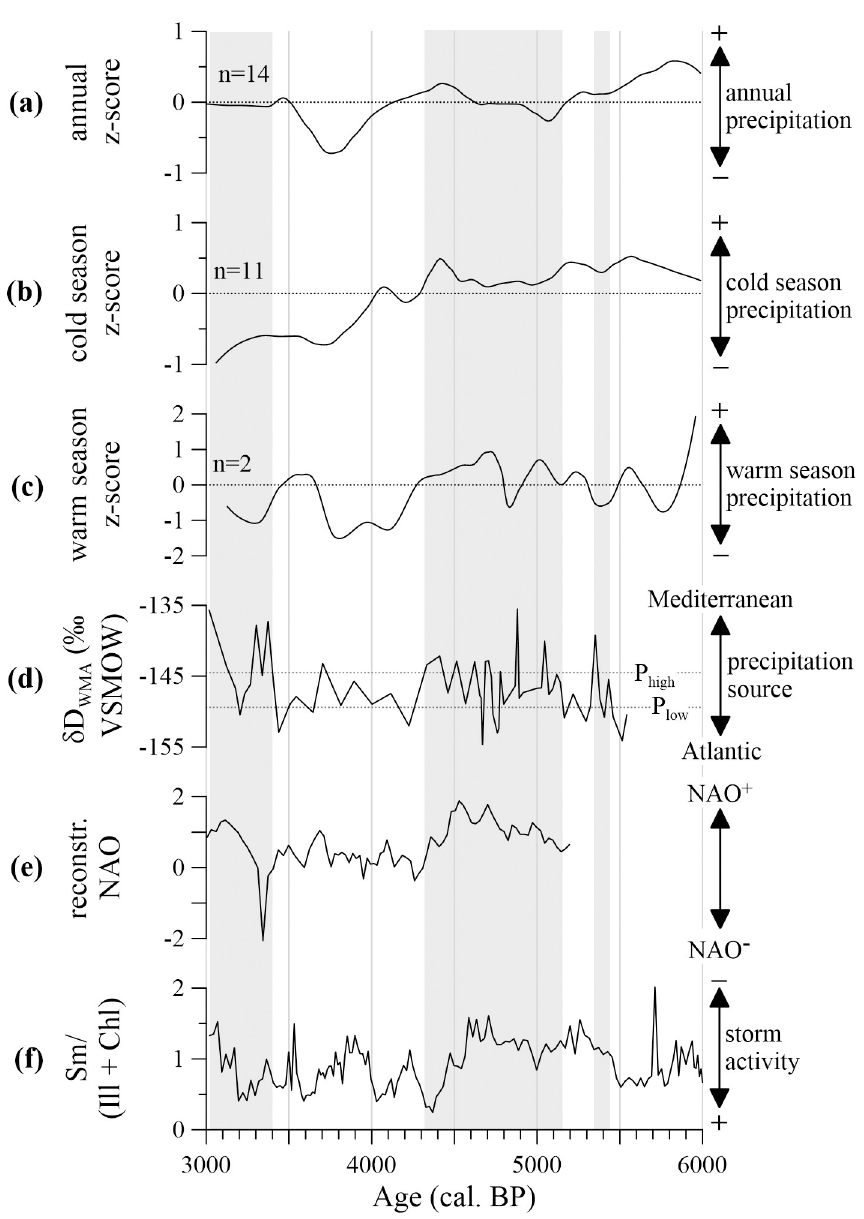
Fig 4. Atlantic versus Mediterranean influence. a) Regional z-score of annual precipitation variability, b) regional z- score of cold season precipitation variability, and c) regional z-score of warm season precipitation variability. Numbers of individual archives (n) included into the regional data are also shown. d) Weighted-mean average hydrogen isotopic data ( δ D WMA ) is displayed together with means of periods characterized by prolonged high (P high ) and low δ D WMA values (P low ) for orientation (see results-section). e) Reconstructed NAO from lake SS1200 in Greenland [87] and f) clay mineral ratio of Smectite (Sm), Illite (Ill), and Chlorite (Chl) from Gulf of Lions sediment core PB06 indicative of Western Mediterranean storminess [88] are shown for interpretation. Vertical grey bars indicate periods of increased Mediterranean precipitation in southeast Iberia based on the hydrogen isotopic data from